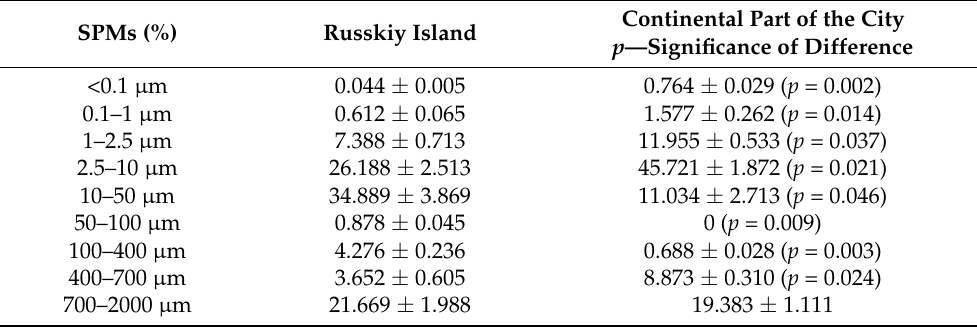
Table 1. The content of atmospheric surface layer SPMs (%) of different size ranges in the continental and island parts of Vladivostok.